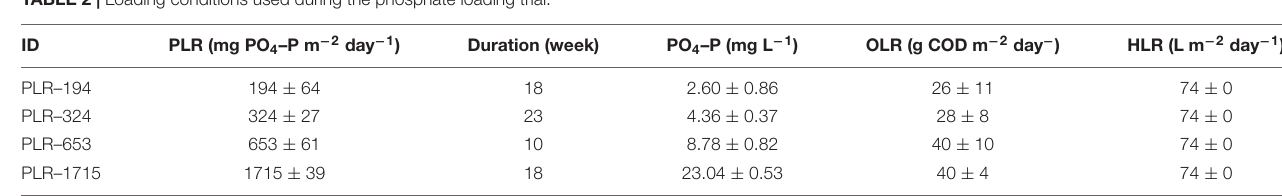
TABLE 2 | Loading conditions used during the phosphate loading